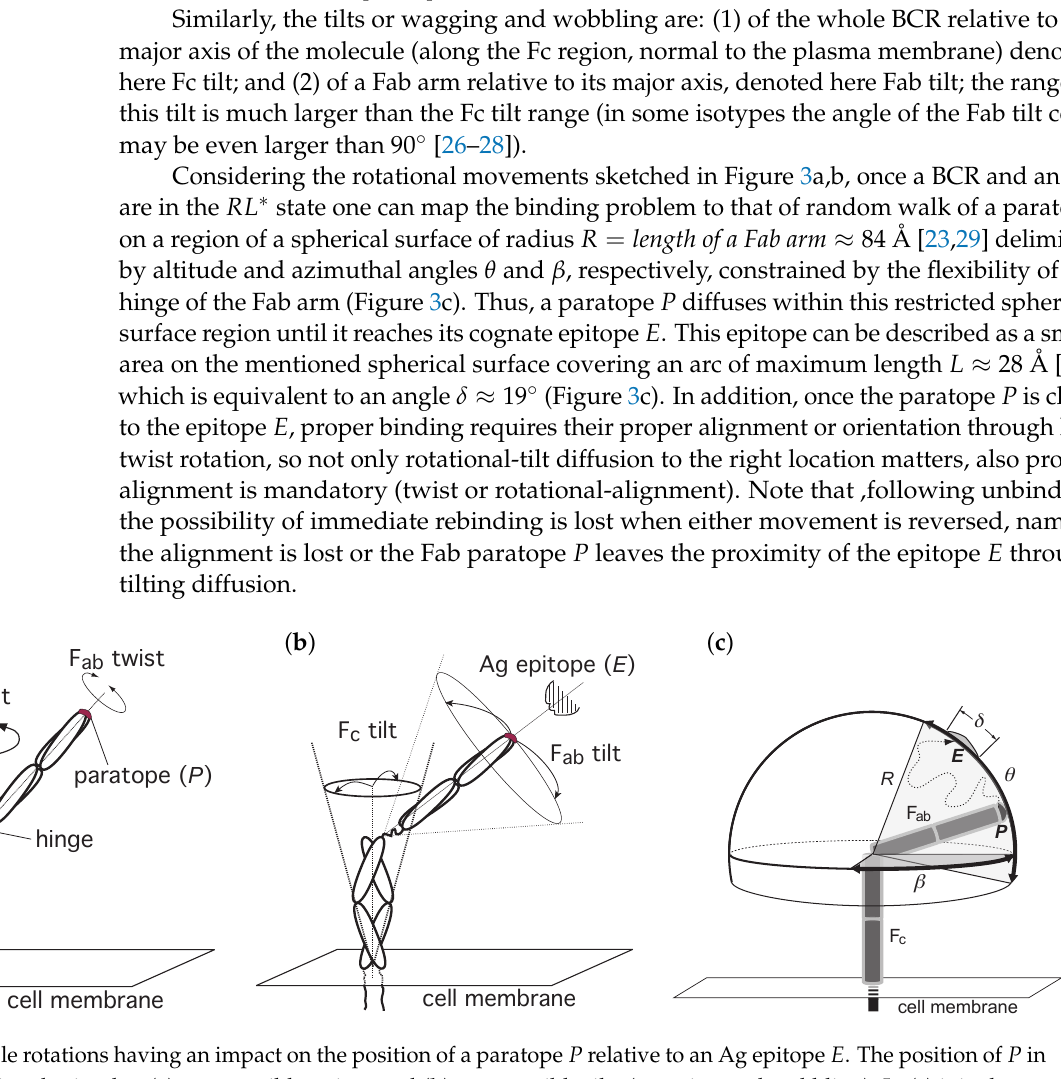
Figure 3. Possible rotations having an impact on the position of a paratope P relative to an Ag epitope E . The position of P in a membrane Ig is submitted to ( a ) two possible twists, and ( b ) two possible tilts (wagging and wobbling). In ( c ) it is shown a sketch of the diffusion of P constrained to a spherical cap on a sphere of radius R = length of a Fab arm ≈ 84 Å [29] and to Fab altitude and azimuth angles θ and β , respectively. Depicted is a possible path followed by paratope P toward epitope E (dotted line). This movement corresponds to Fab tilt in ( b ). The angle δ corresponds to an arc on the spherical surface equal to the major length of E . For clarity, in all panels the membrane Ig is depicted with only one Fab